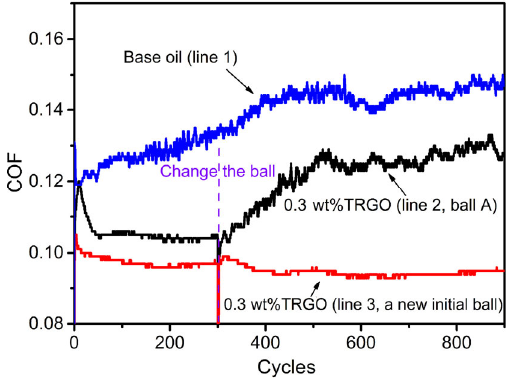
Fig. 6 COFs of steel/steel friction pairs at 15 N.